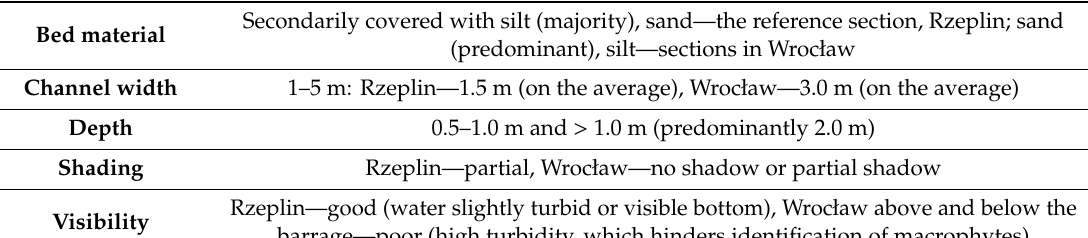
Table 5. Complementary information about the sections selected for the MMOR analysis.